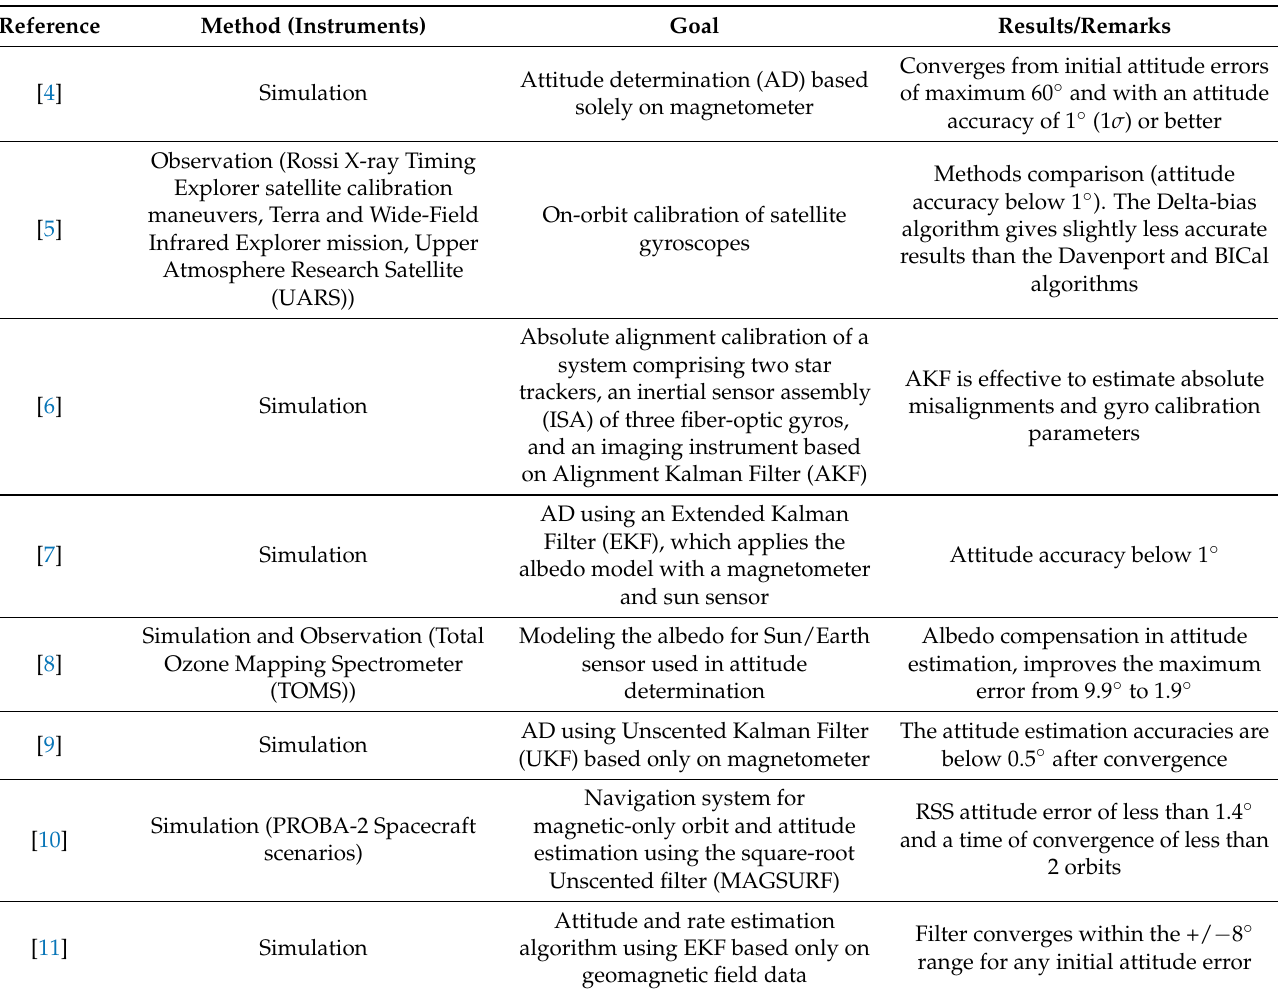
Table 1. Studies related to attitude determination (simulation and in-orbit